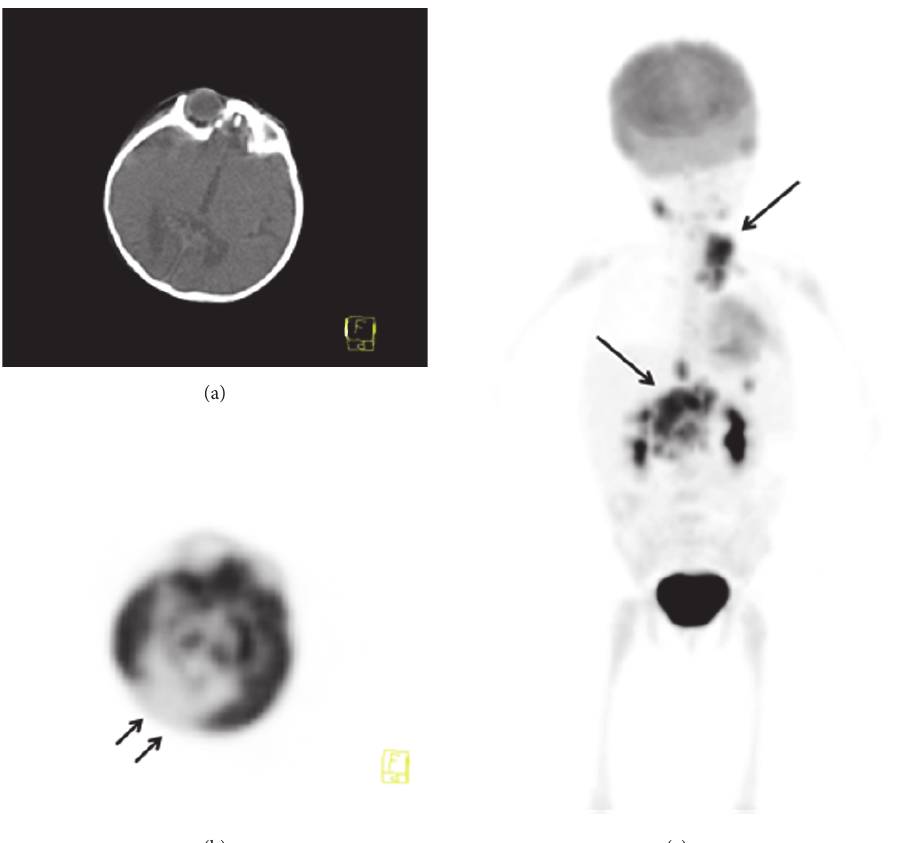
Figure 1: (a, b) In the cranial axial images of FDG PET/CT scan, hypometabolism in the occipital regions bilaterally was seen (arrows) and (c) maximum intensity projection (MIP) images of the staging PET/CT examination demonstrated focal increased FDG uptakes in the lymph nodes on the cervical and abdominal regions (long